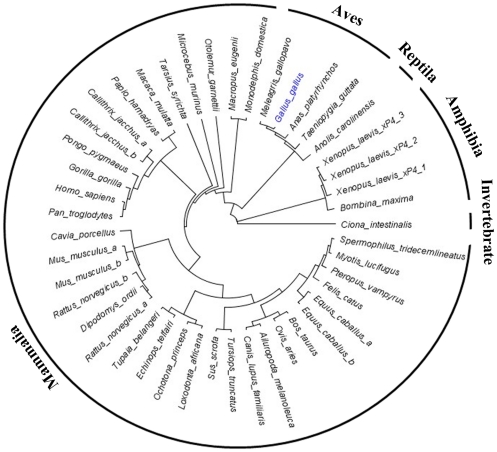
Phylogenetic tree of TFF2.Forty five TFF2 proteins and related structure were aligned by using ClustalW, and the neighbor-joining tree derived by the same program was shown. A. carolinensis: anole lizard. G.gallus: chicken. P. hamadryas: baboon. A. melanoleuca: giant panda. G. gorilla: gorilla. P. pygmaeus: orangutan. A. platyrhynchos: duck. H. sapiens: human. P. troglodytes: chimpanzee. B. maxima: toad. L. africana: elephant. P. vampyrus: megabat. B. Taurus: cow. M. domestica: opossum. R. norvegicus: rat. C. intestinalis: vase tunicate. M. eugenii: wallaby. S. scrofa: pig. C. jacchus: common marmoset. M. gallopavo: turkey. S. tridecemlineatus: squirrel. C. lupus familiaris: dog. M. lucifugus: microbat. T. belangeri: tree shrew. C. porcellus: guinea pig. M. mulatta: macaque. T. guttata: zebra finch. D. ordii: kangaroo rat. M. murinus: mouse. T. syrichta: tarsier. E. caballus: horse. O. aries: sheep. T. truncatus: dolphin. E. telfairi: lesser hedgehog tenrec. O. garnettii: bushbaby. X. laevis: African clawed frog. F. catus: cat. O. princeps: pika.